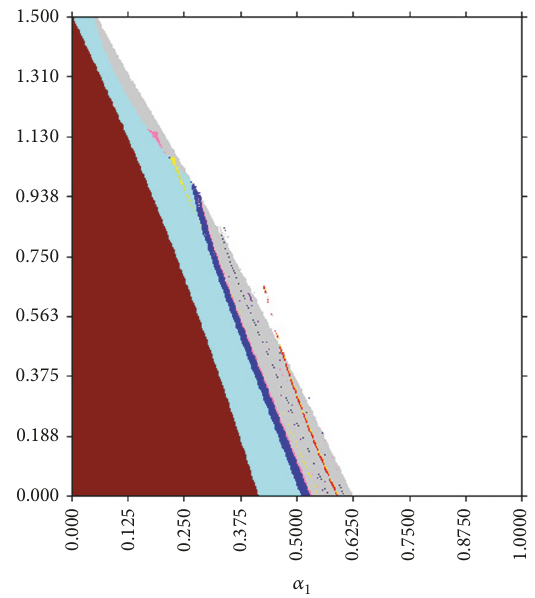
Figure 6: Impact of price cross-elasticity between two channels on system